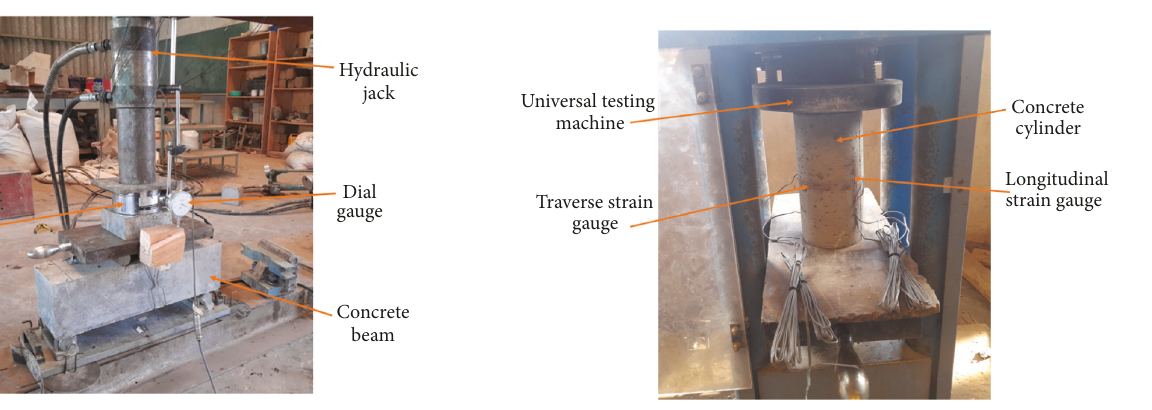
6: Test setup determination of static Young’s modulus and Poisson’s ratio of